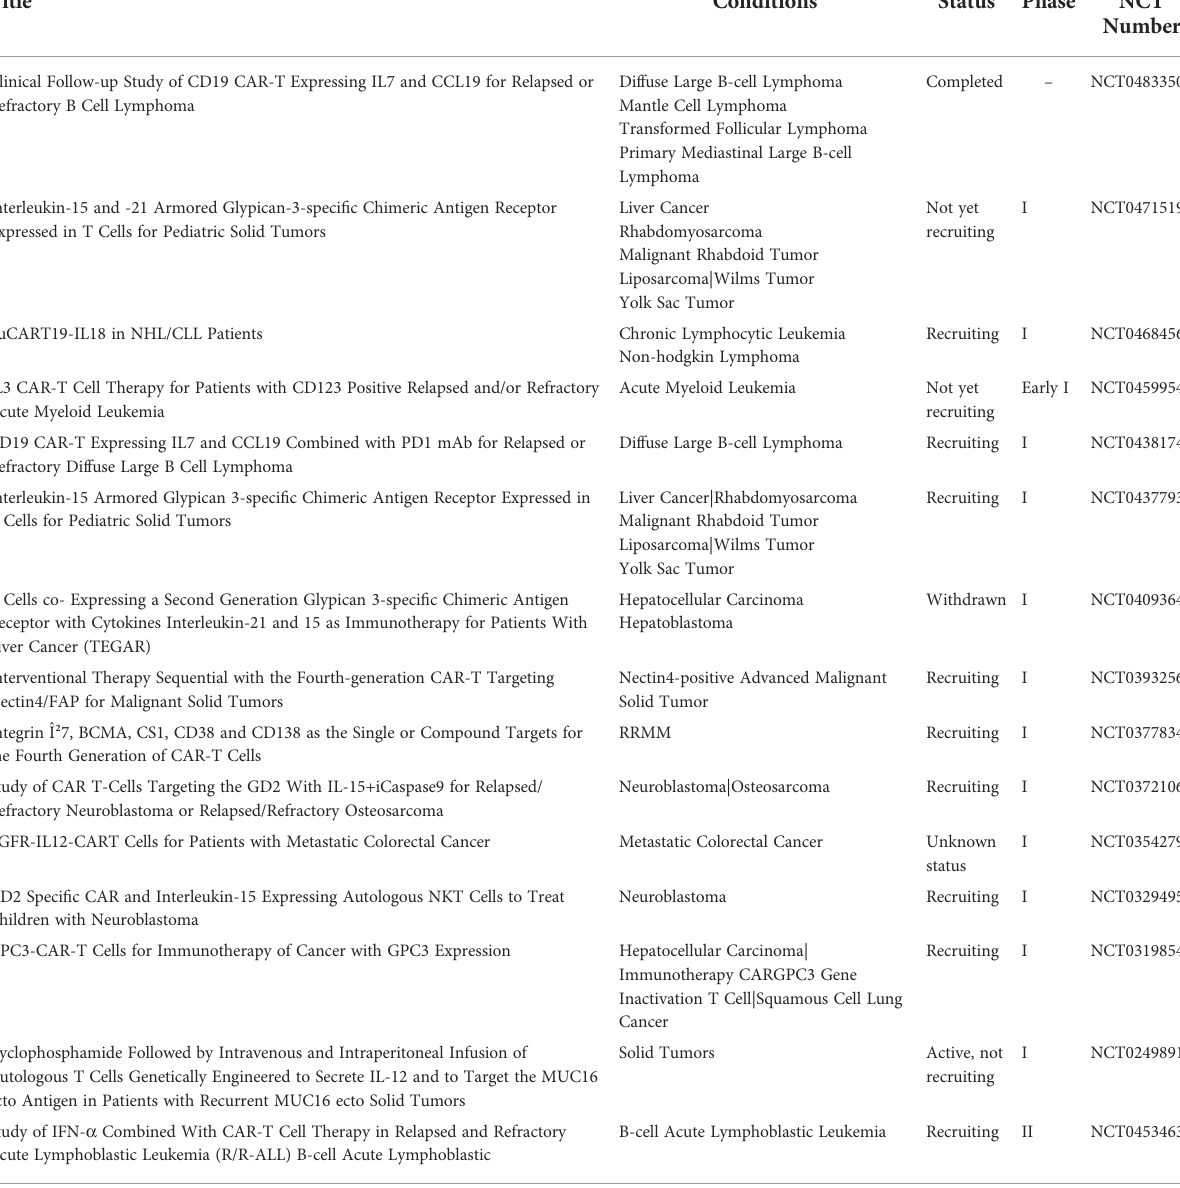
TABLE 2 Clinical trials with TRUCKS cells